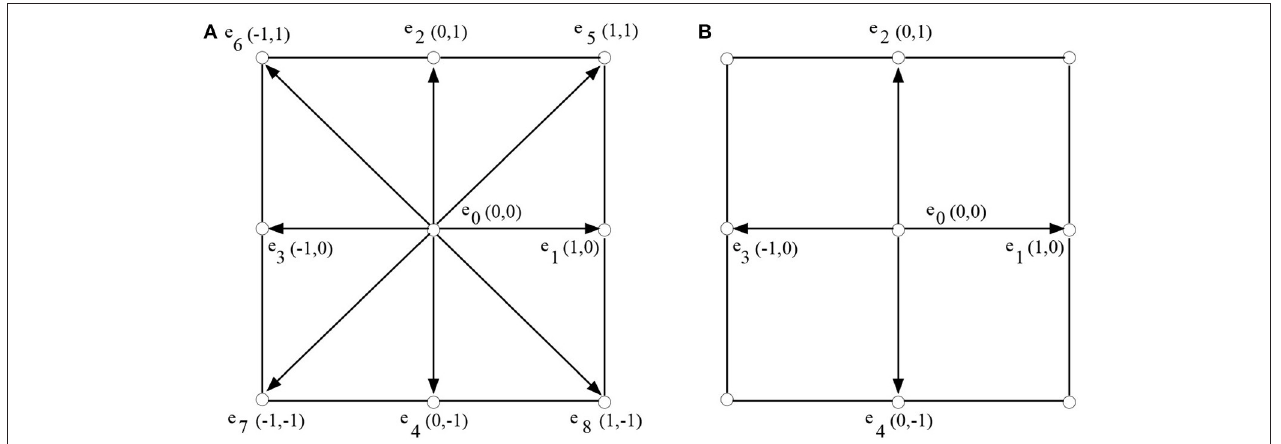
FIGURE 1 | Lattice discrete velocity structure as in Trouette’s paper (Trouette, 2013) (A) D2Q9 and (B) D2Q5